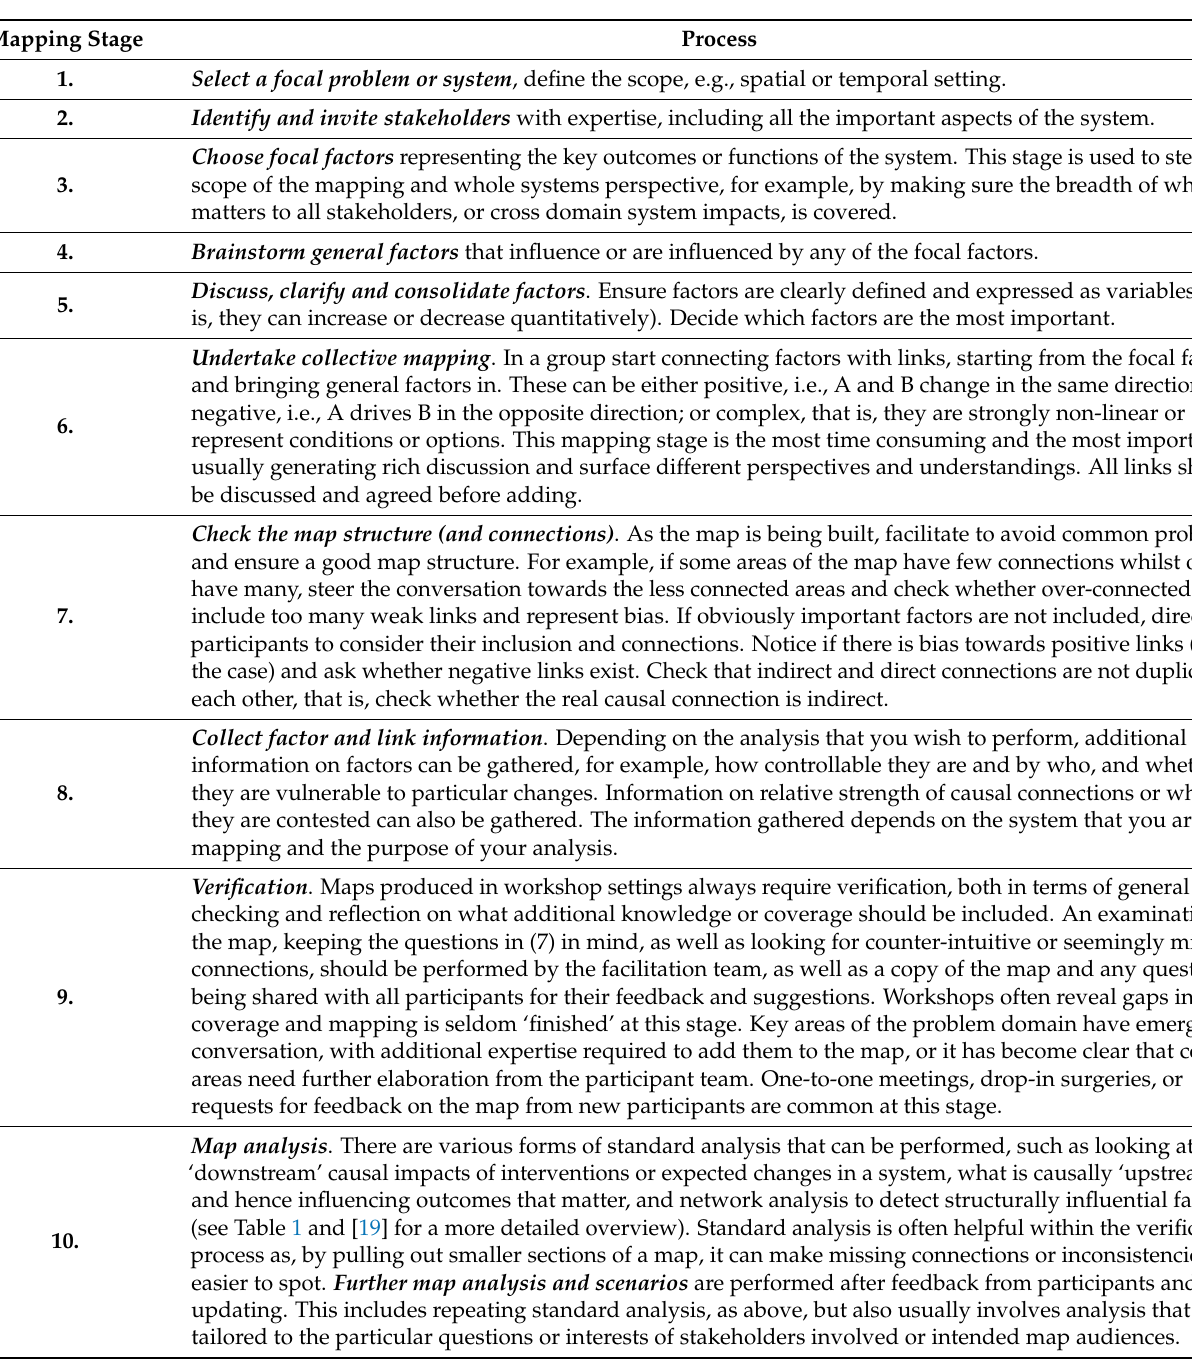
Table 2. A standard participatory systems mapping